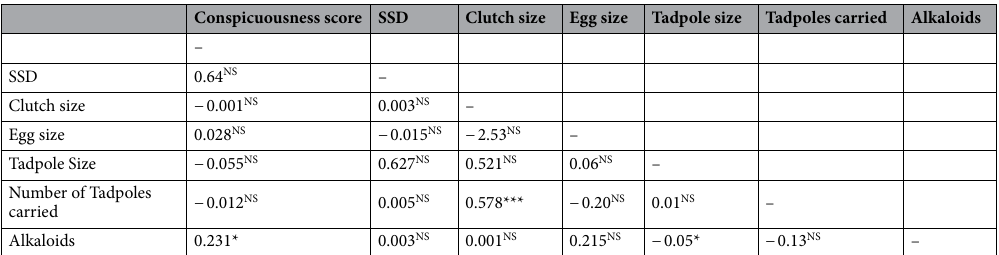
Table 3. Comparison between ß values of independent phylogenetic regressions. The coefficient significance is indicated by *(superscript) for P < 0.05 and NS (superscript) for P > 0.05. All P -values were adjusted for false discovery rate (FDR). A longer version is provided in Table